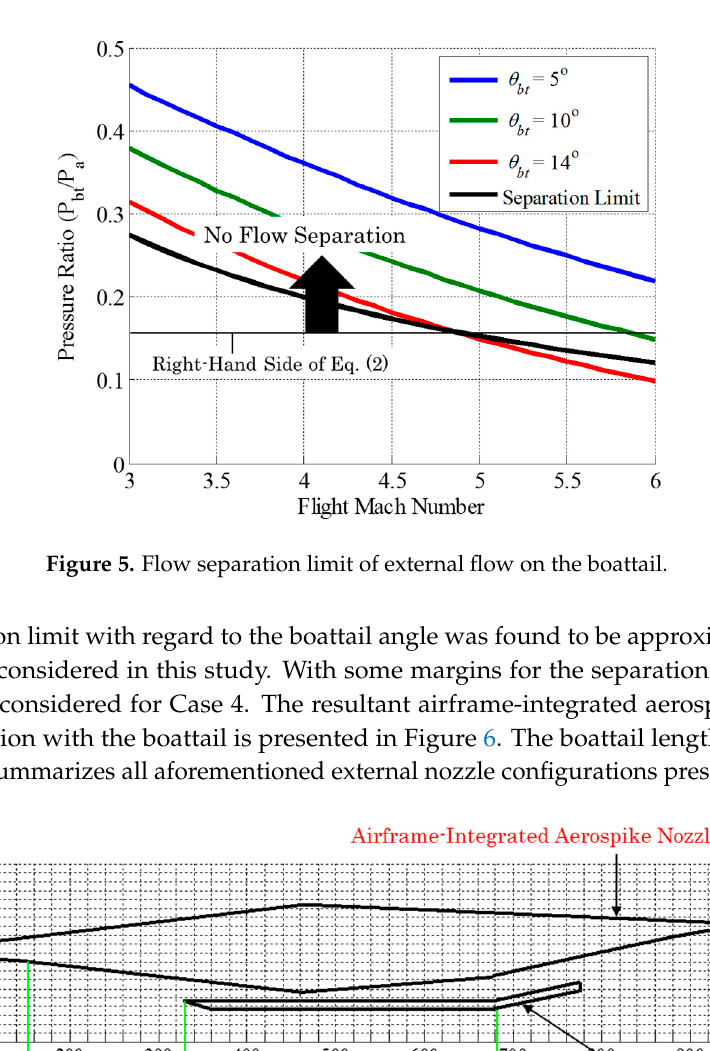
Figure 6. Illustration of a center cut of the airframe configuration equipped with the airframe- integrated linear-spike aftbody nozzle with the boattail.